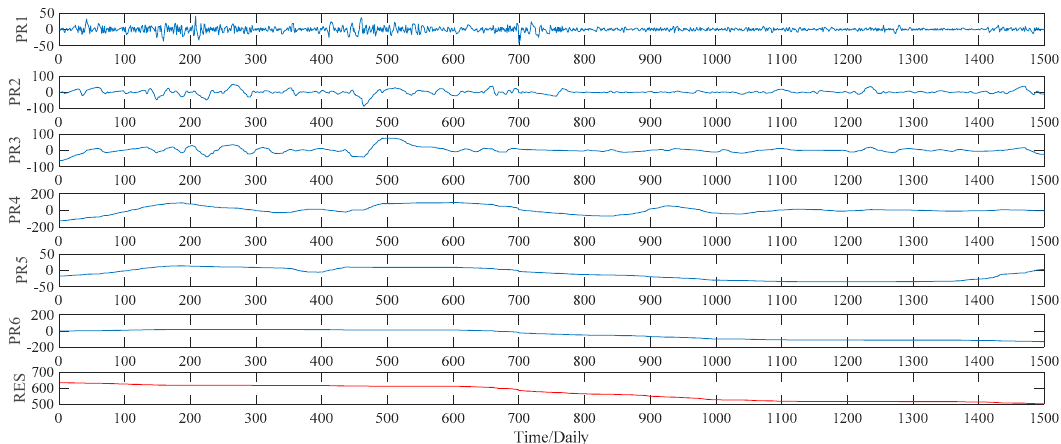
Figure 15. Decomposition results of the ITD method (corn).